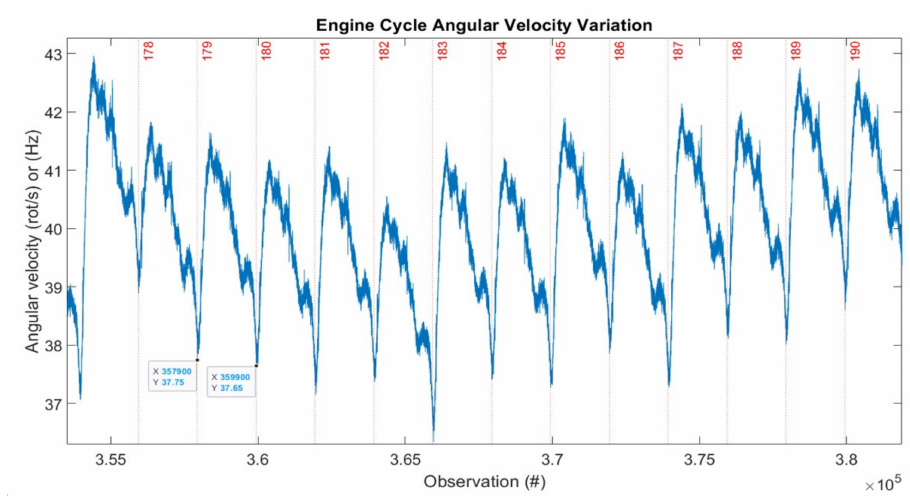
Figure 14. Representation of 12 consecutive engine cycles c178 to c190. # = number. The thermodynamic cycle in the ICE’s combustion chamber drives the piston, connect- ing rod, crankshaft, and the power consumer—here, the propeller—at an angular velocity with a typical variation shown for one EC in Figure 15 (i.e., for 2000 samples—two engine shaft revolutions marked with vertical grid lines from 0 to 4 π ). On this graph, one can identify the differences between the theoretical and real-time dynamically measured points. The characteristic represented in Figure 15 is that of a complete EC—one observation to every 1/1000 revolutions. This resolution largely exceeds the requirement of 1 observation per degree to qualify as a cycle resolved.